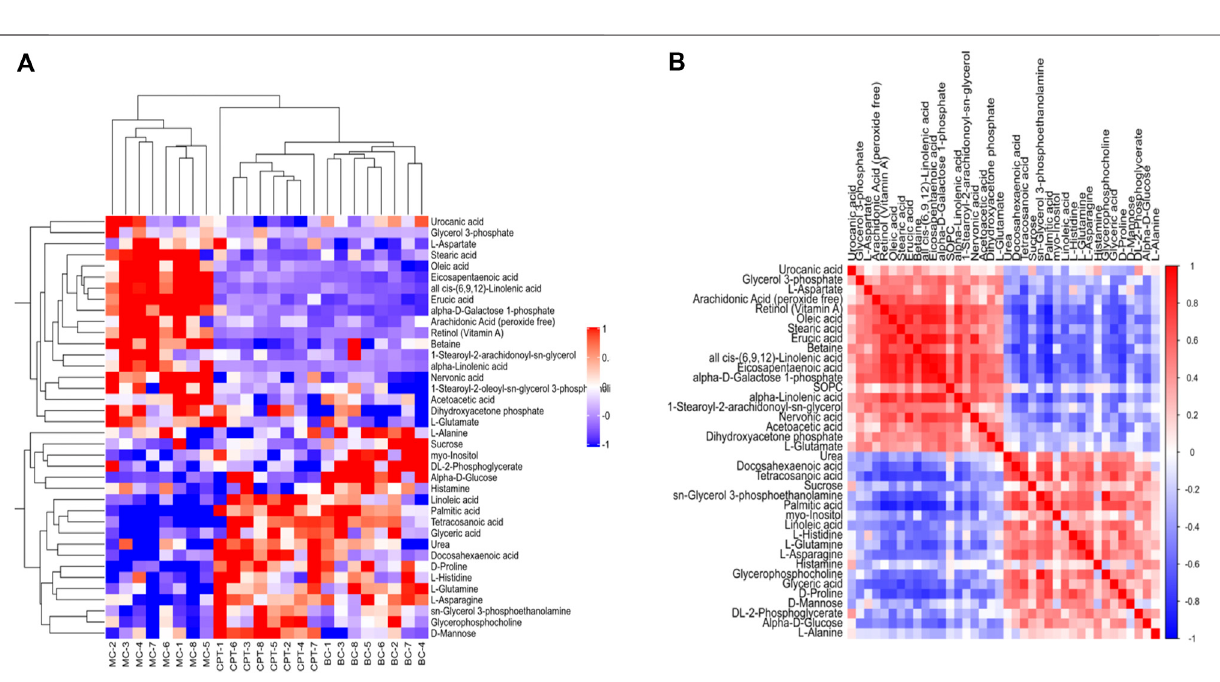
FIGURE 7 | (A) Hierarchical clustering heat map of skin DEMs. Cluster of the DEMs (right side) and the samples of each group (bottom) are shown. The color from red to blue showed the relative intensity of the DEMs (B) Pearson ’ s correlation of DEMs in CPT and MC groups. Red and blue represent the positive and negative correlation of DEMs,